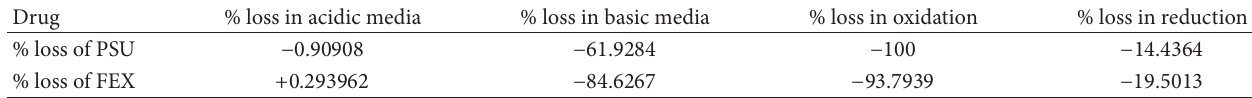
Table 7: Result of forced degradation study.